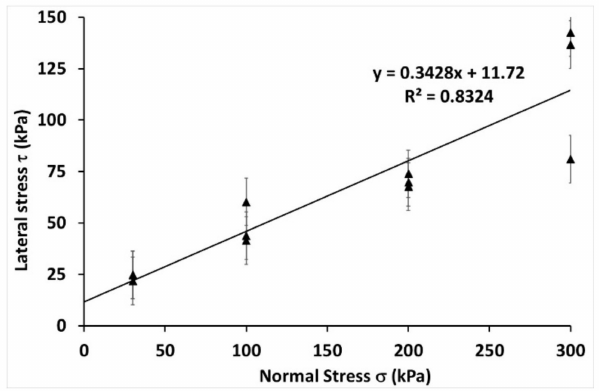
Figure 11. Particle–wall coefficient of friction obtained for maize in direct shear